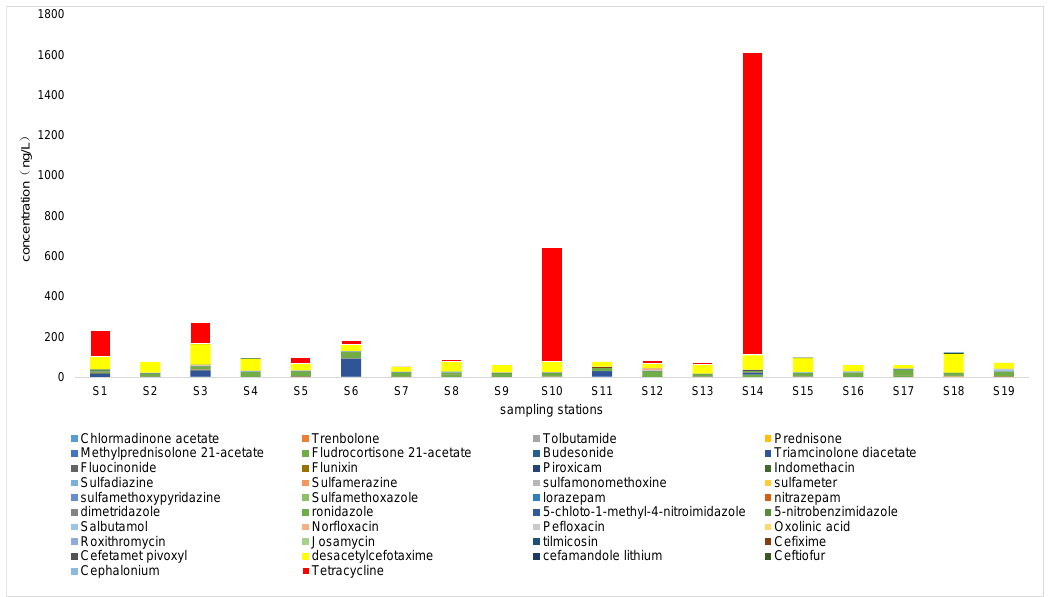
Figure 2. Cumulative levels of pharmaceutically active compounds (PhACs) at the different sampling stations.